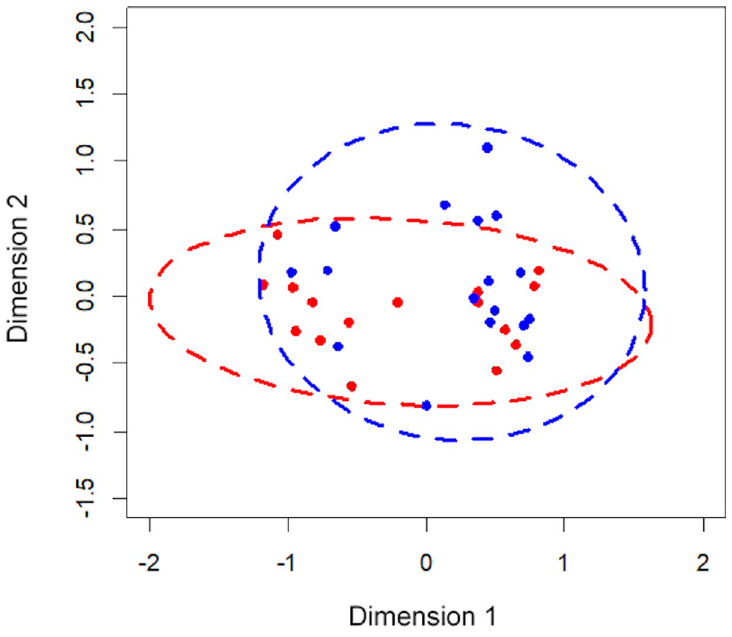
Fig 3. The Non-metric Multidimensional Scaling (NMDS) plot based on bacterial composition of patients on high-dose ICS taking budesonide (red) and fluticasone propionate (blue). The shorter the distance between the dots, the more similar the bacterial compositions were between the